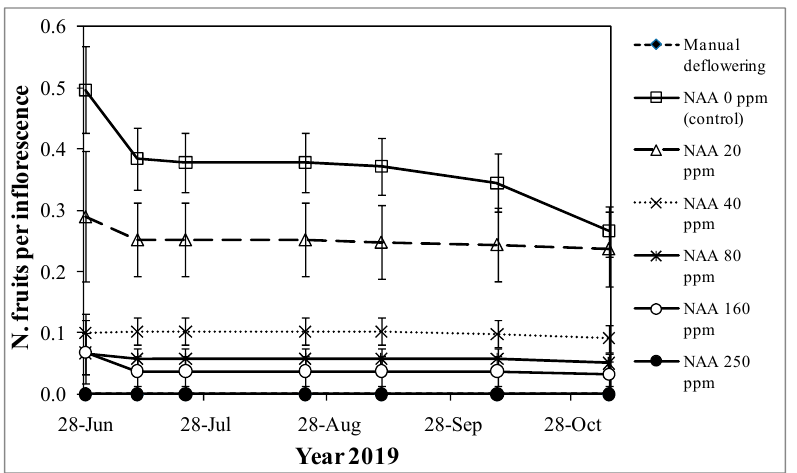
Figure 1. Fruit set and drop during the growing season (2019) in control, different NAA concentra- tions, and manually deflowered trees in a young intensive olive orchard of the cultivar Moraiolo. The bars represent the standard error of 16 replicates per treatment. The dashed line for manual deflowering is difficult to see because it overlaps with the solid line for the NAA 250 treatment.